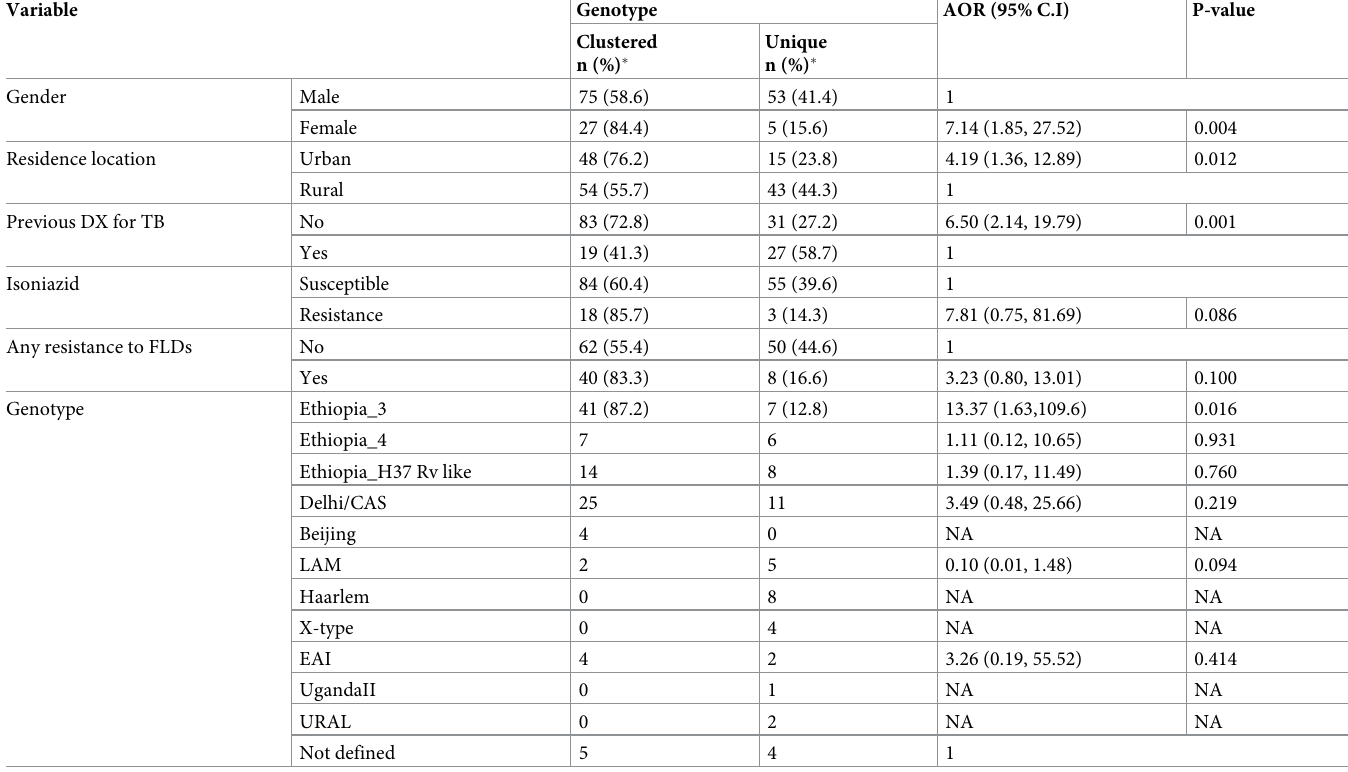
(cid:3) Percentage is calculated from row total; FLDs: first line anti-TB